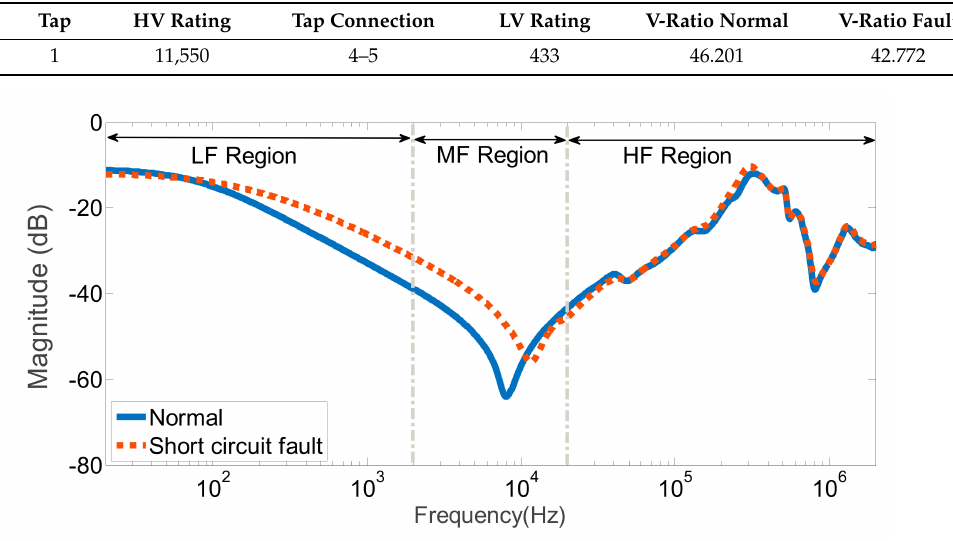
Figure 12. Measured FRA for normal and short circuit faults. Table 6. Correlation coefficient